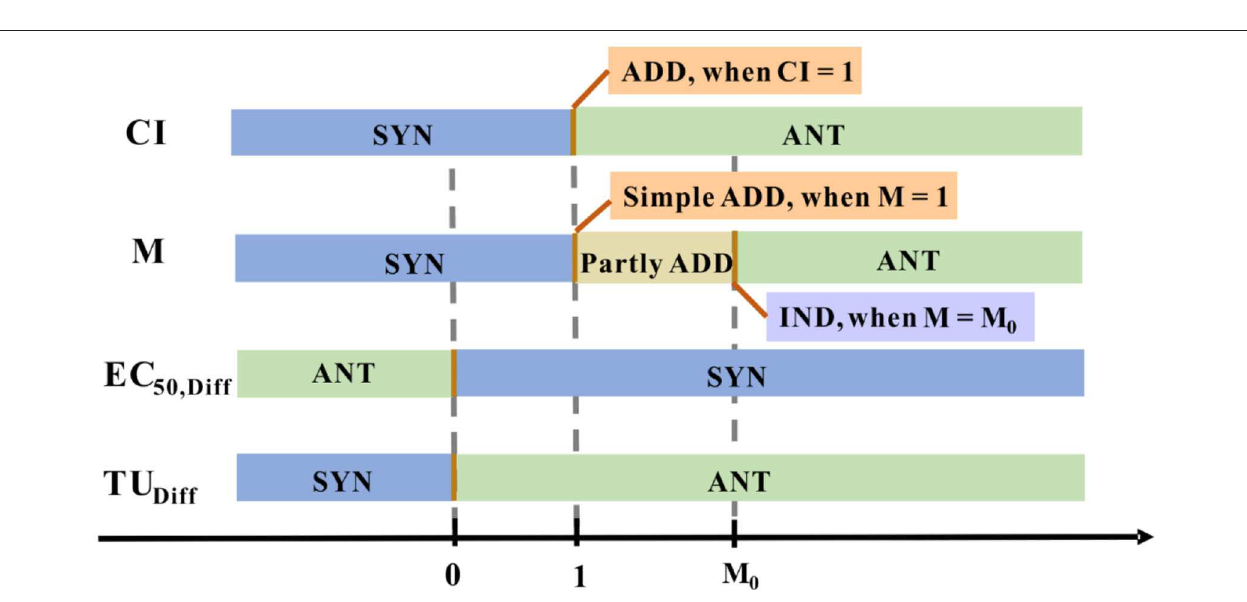
FIGURE 5 | The joint effect is quantified numerically using different methods. Distinctive colored blocks represent a distinctive joint effect